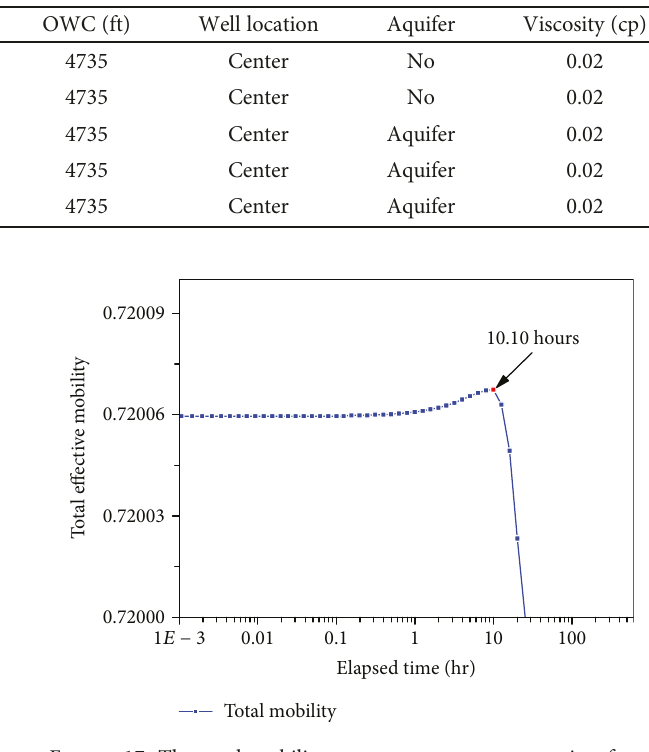
Figure 16: The log-log plot of gas-water reservoir with closed boundary. The pressure derivative starts to increase from 10.10